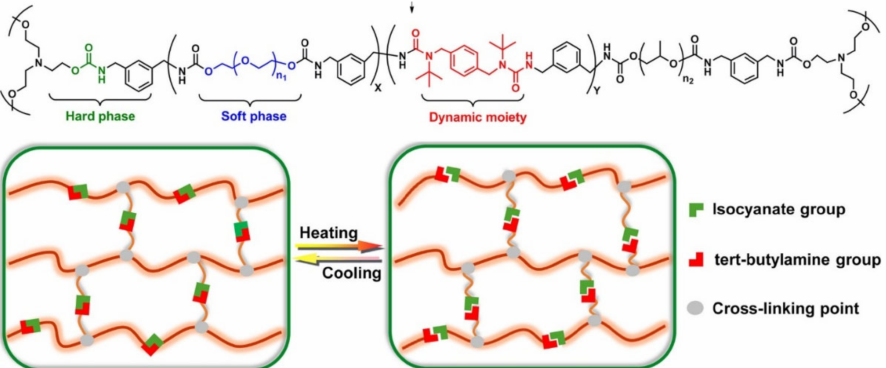
Figure 26. Diagram of PU networks and their self-healing mechanism. Reprinted with permission from [165]. Copyright (2020) American Chemical